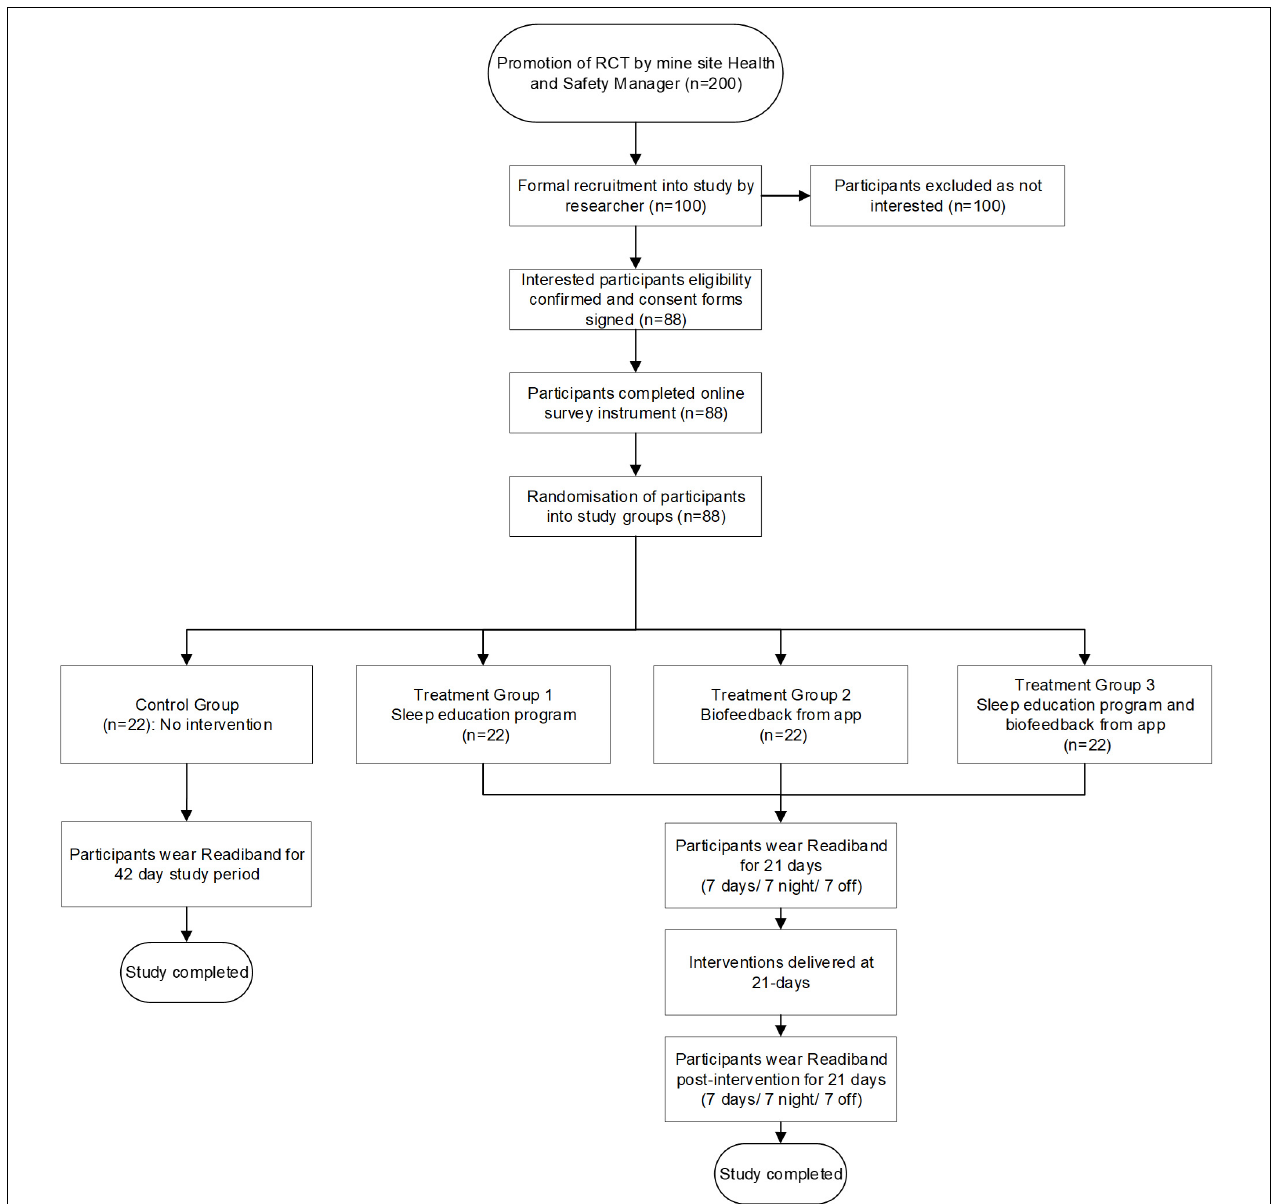
FIGURE 1 | RCT design and flow of participants through the